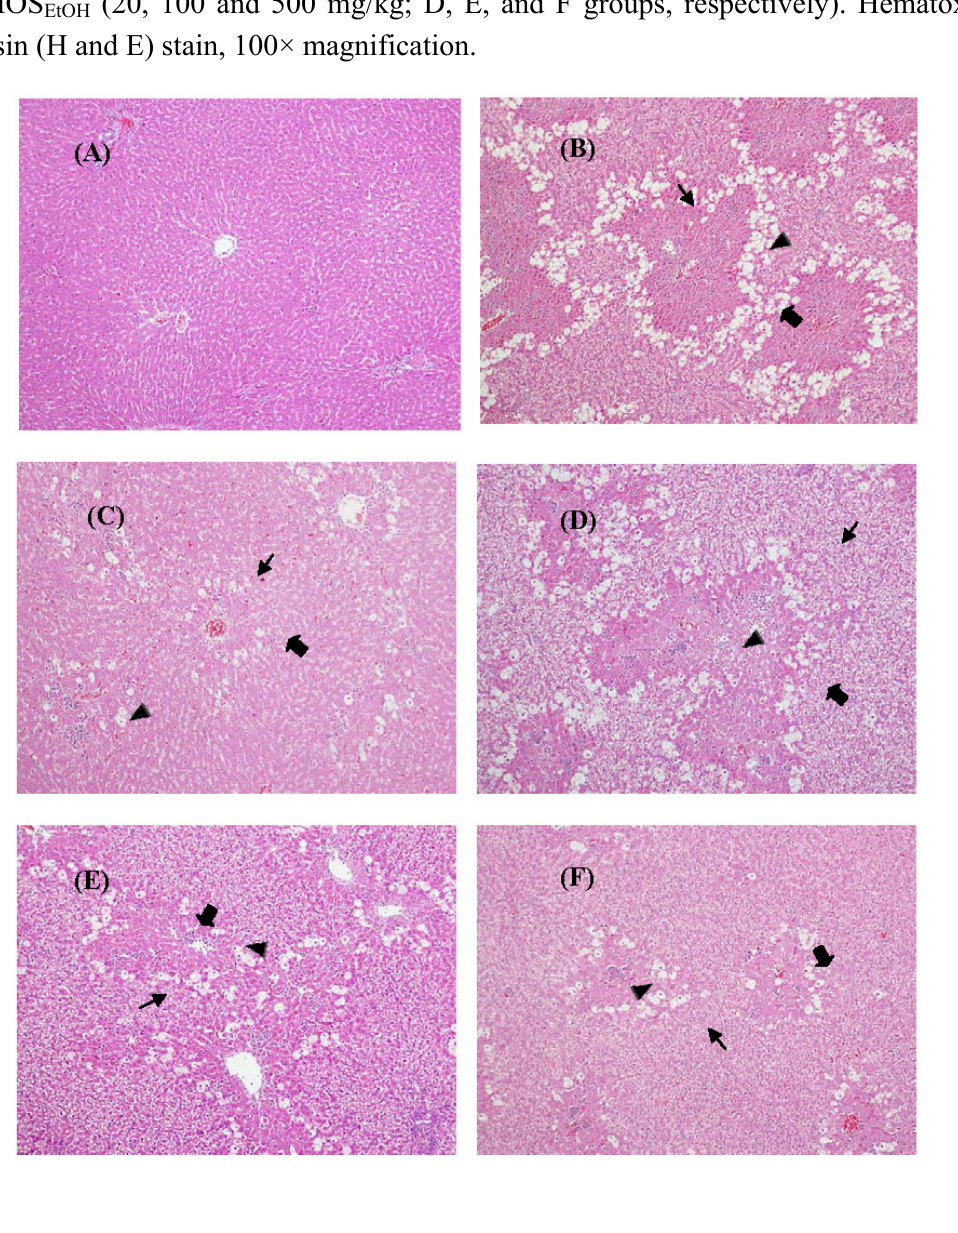
various group of animals. The serum levels of ALT and AST in untreated control group of animals were 112.5 ± 11.2 U/L and 85.7 ± 9.3 U/L, respectively. After CCl treatment, the serum ALT and 4 AST activities increased by approximately 16.9 and 18.4-fold compared to the control group. In contrast, the serum AST and ALT levels showed a significantly lower increase when the rats were treated with MOS compared to the CCl alone group of rats. Similar results were obtained when EtOH 4